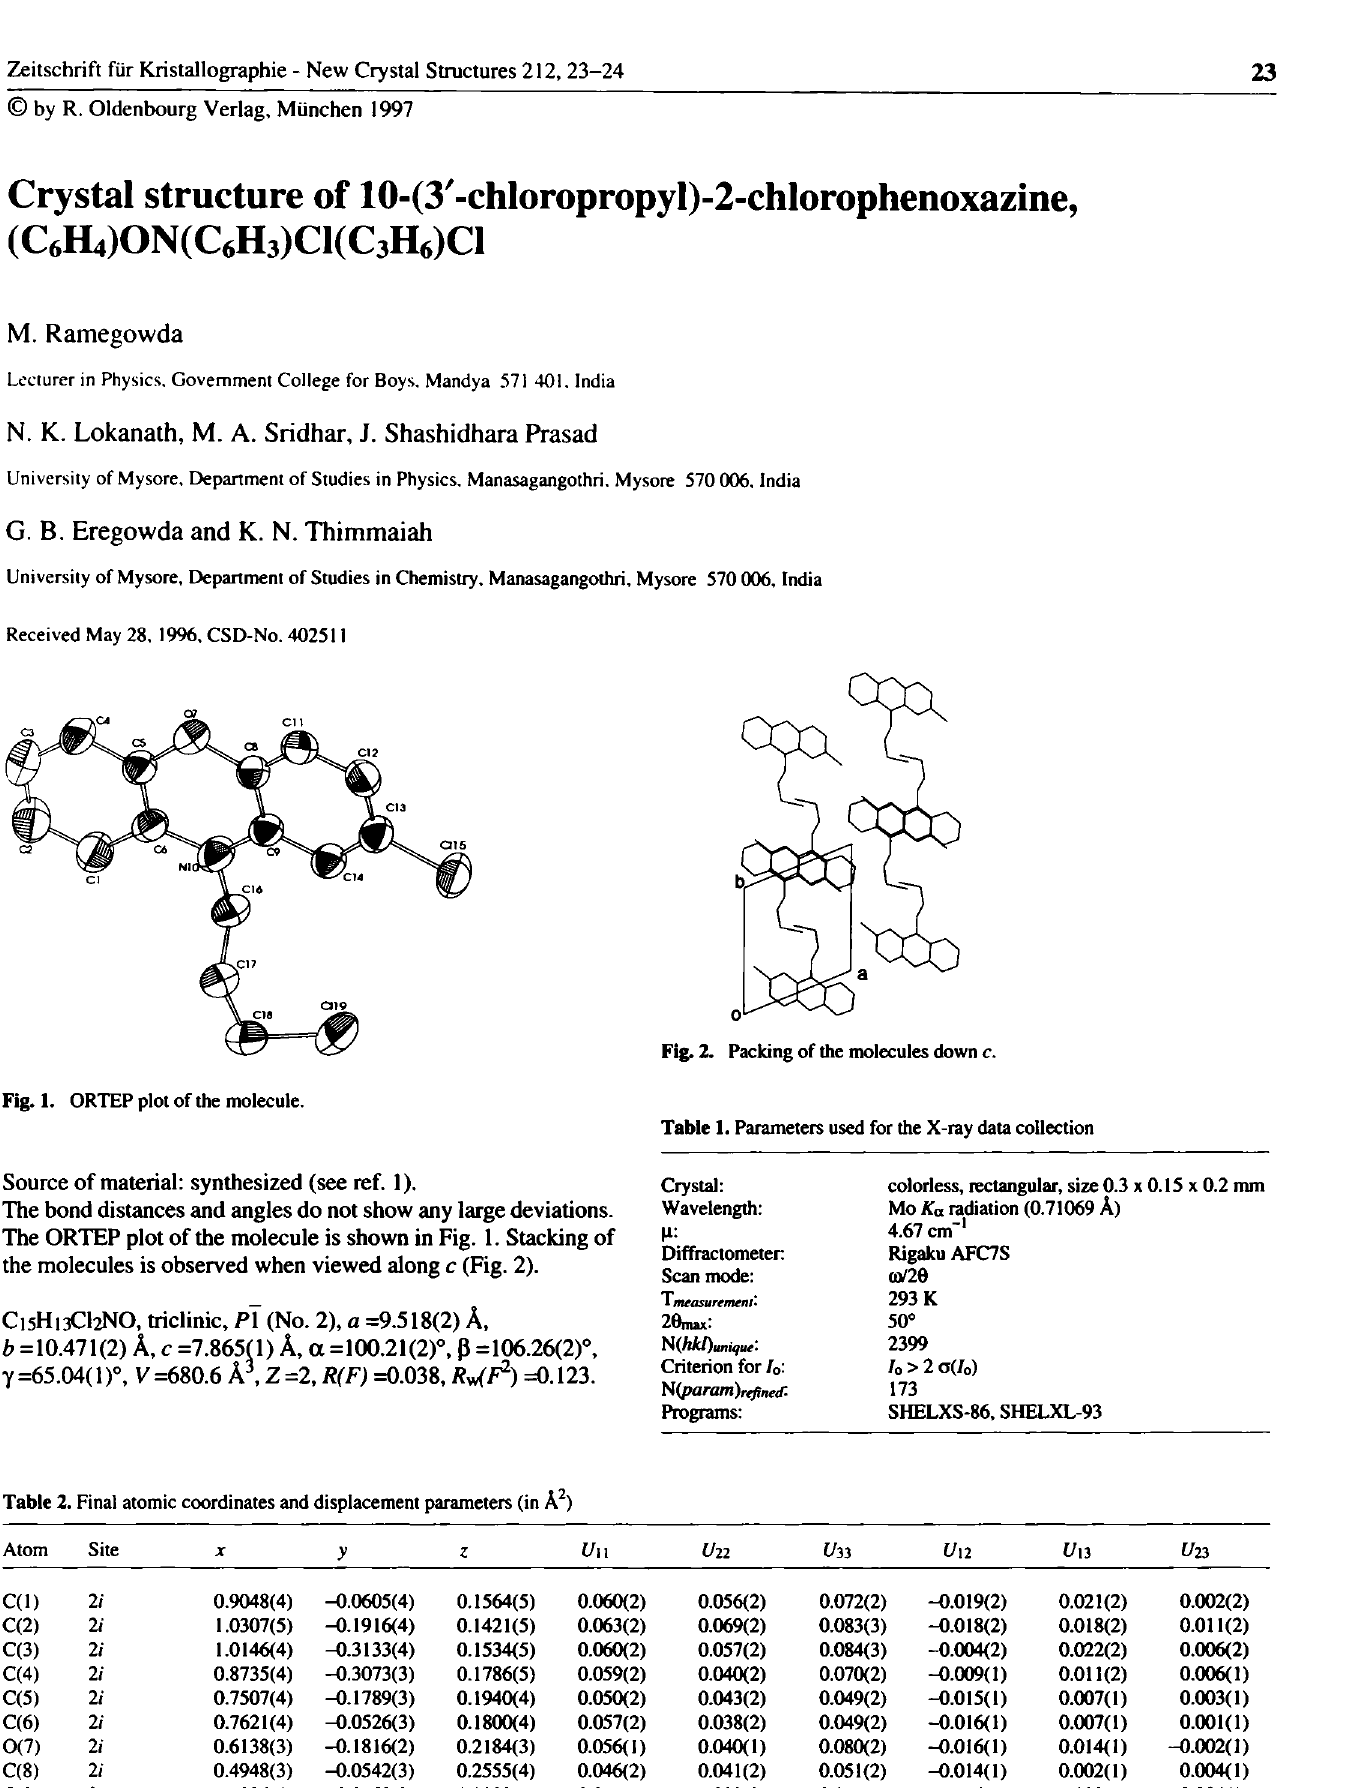
Table 2. Final atomic coordinates and displacement parameters (in Â 2